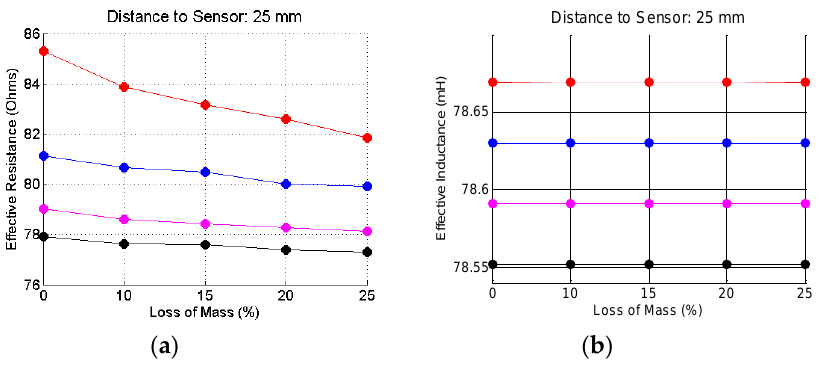
Figure 16. Resistance ( a ) and inductance ( b ) for the steel bars at the reference distance of 25 mm.